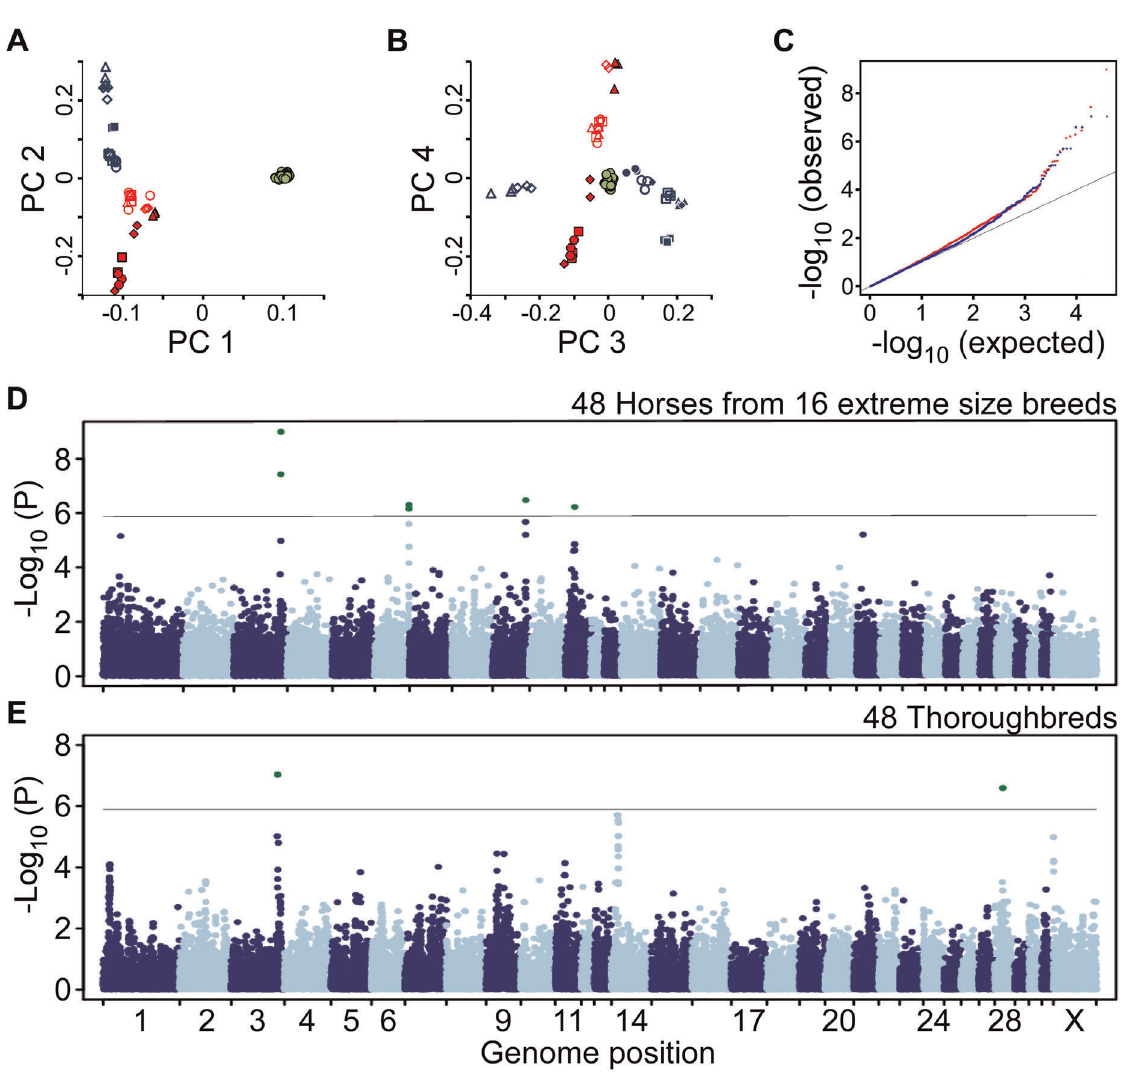
Figure 1. Two genome-wide association scans for size identify five significantly associated loci. (A) Horse breed phylogenetic relationships were inferred using a principal components analysis of SNP genotypes collected from 48 horses from 16 extreme size breeds plus 48 Thoroughbreds. Thoroughbreds (filled green circles) and other breeds have distinct genetic signatures. Large breeds (blue points) are genetically clustered in PC-space as are small breeds (red points). The first four PCs are plotted: PC1 (9.7% of variance explained) and PC2 (2.7%) and in (B) PC3 (2.4%) and PC4 (2.0%). Breeds in size order: American Miniature = filled red squares, Falabella = filled red circles, Caspian = filled red triangles, Shetland Pony = filled red diamonds, Welsh Mountain Pony = unfilled red squares, Welsh Pony = unfilled red circles, Dartmoor Pony = unfilled red triangles, Puerto Rican Paso Fino = unfilled red diamonds, Friesian = filled blue squares, Suffolk Punch = filled blue circles, Ardennais = filled blue triangles, Brabant = filled blue diamonds, Belgian = unfilled blue squares, Percheron = unfilled blue circles, Clydesdale = unfilled blue triangles, and Shire = unfilled blue diamonds. (C) Quantile-quantile plot for the GWA scans. The p-values for the 16 breed scan are plotted in red and have a genomic inflation factor of 1.189. The p-values for the Thoroughbred scan are plotted in blue and have a genomic inflation factor of 1.114. (D) Manhattan plot for the GWA scan of 48 horses from 16 breeds of extreme size and (E) 48 Thoroughbreds. The horizontal line in each indicates genome-wide significance with an alpha =0.05 and Bonferroni correction for multiple hypothesis testing.